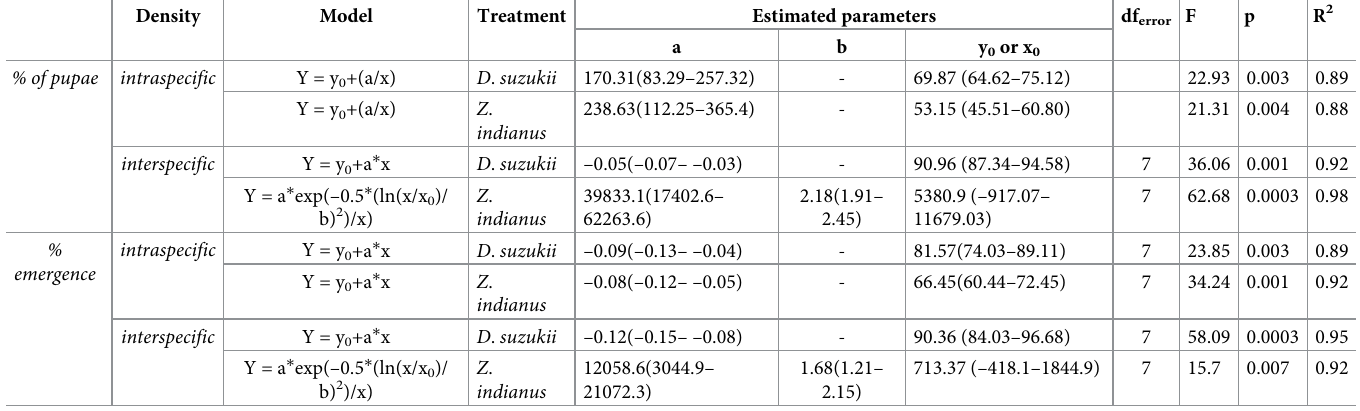
Table 1. Summary of regression analyses for percentages of egg-pupa and pupa-adult viability and adult emergence of Drosophila suzukii and Zaprionus indianus (shown in Fig 2).